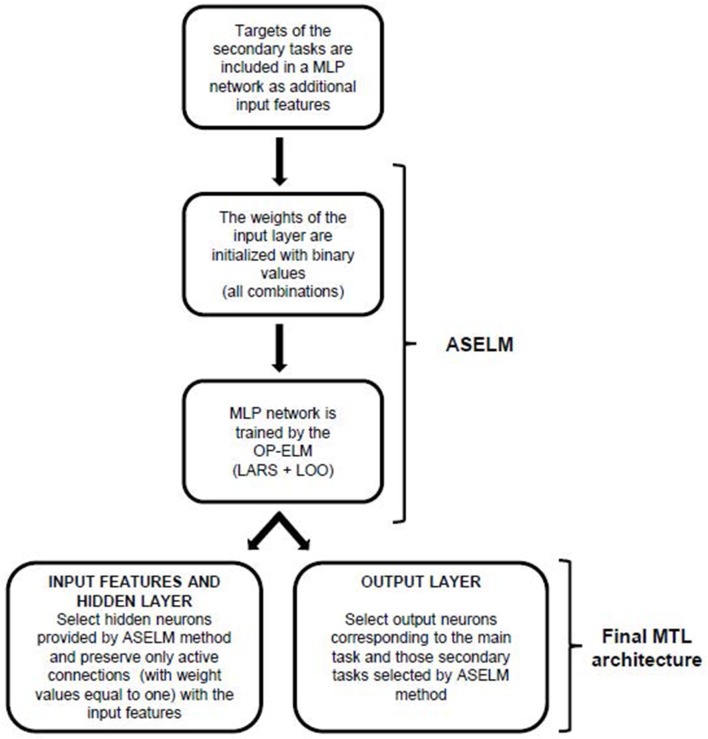
Flowchart of the proposed method.